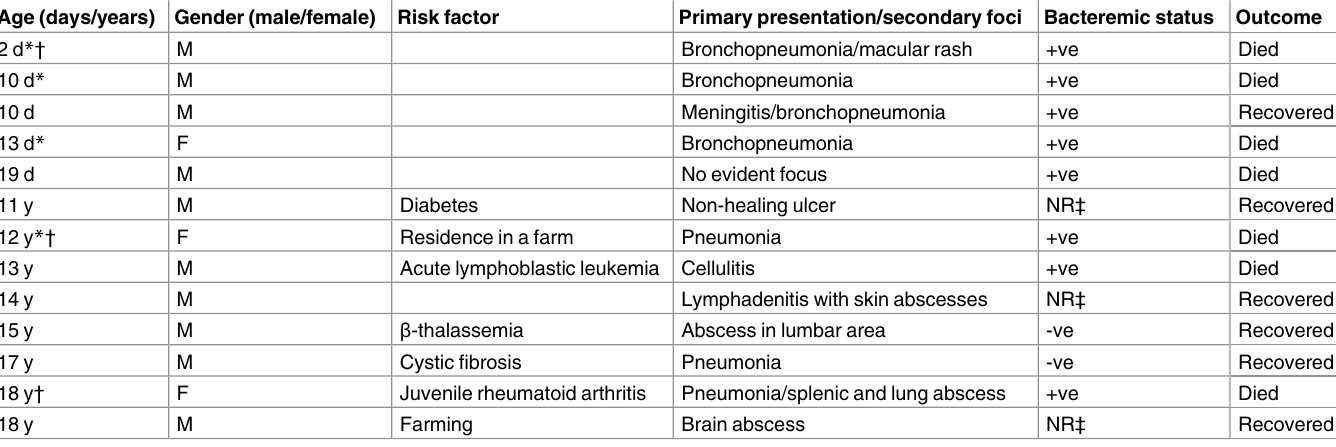
Table 6. Selected characteristics of pediatric cases ( (cid:20) 18 years). Age (days/years) Gender (male/female) Risk